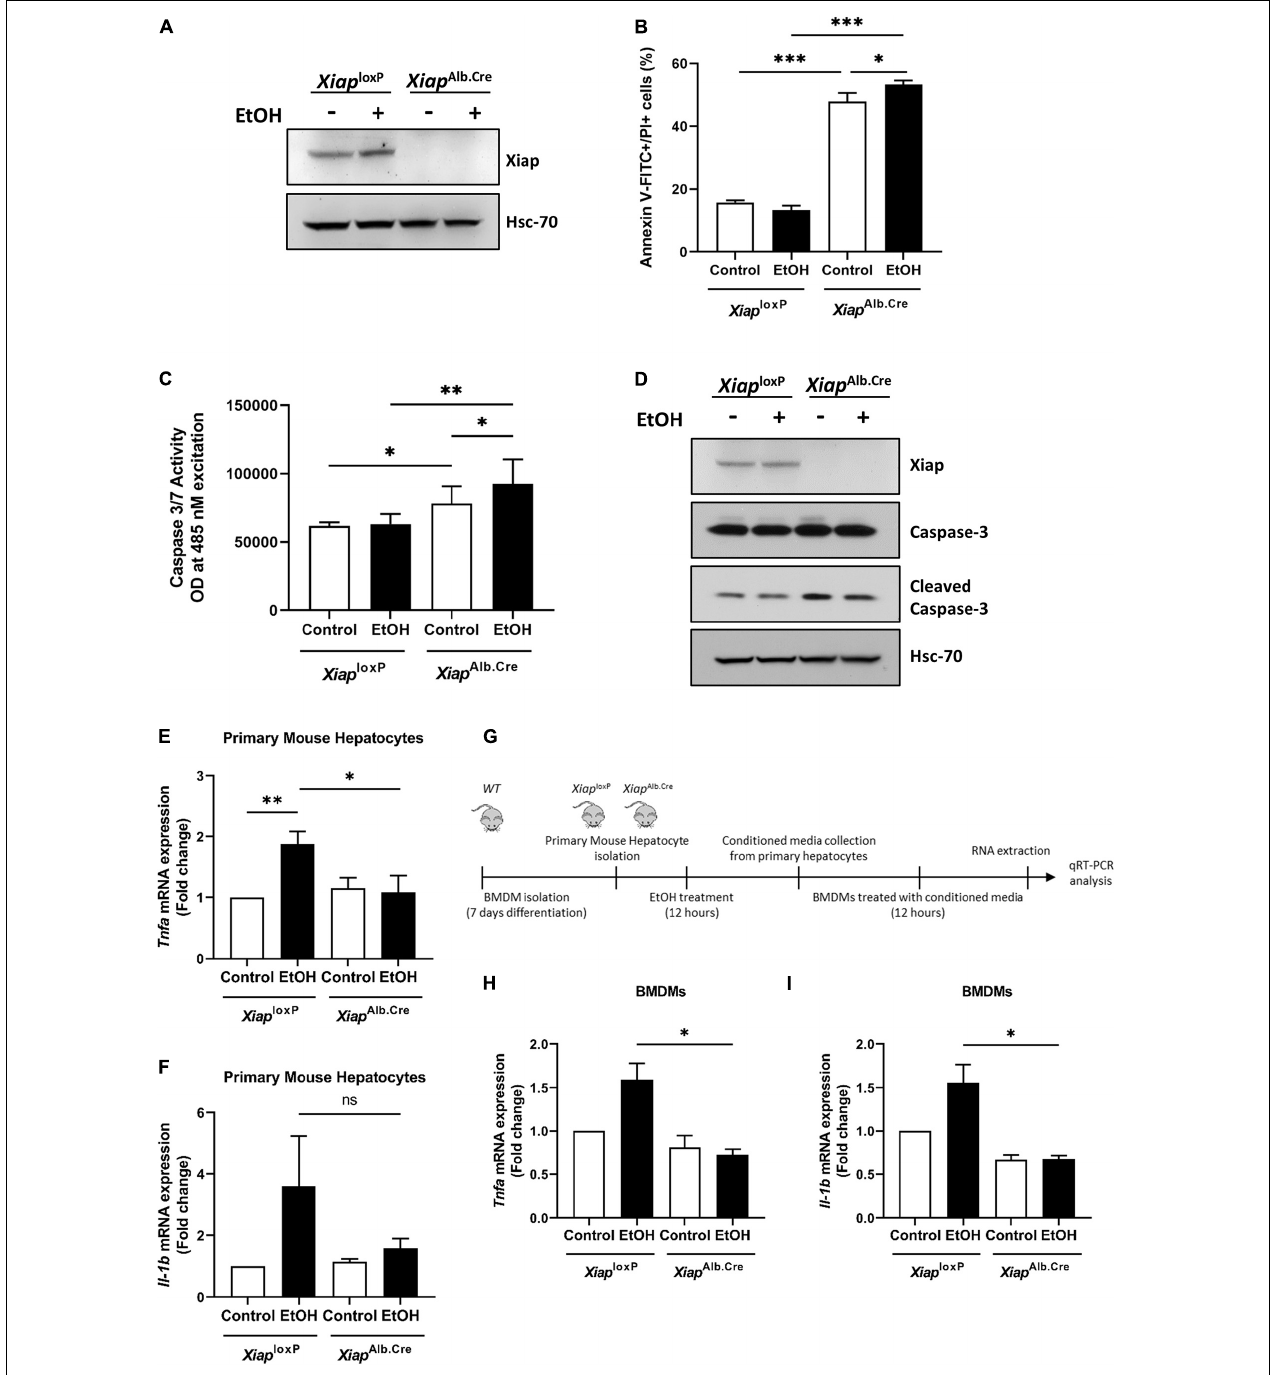
FIGURE 2 | Hepatocyte-selective knockout of Xiap modulates apoptosis and inflammation in PMH. (A) Evaluation of Xiap deletion in primary hepatocytes isolated from Xiap loxP and Xiap Alb . Cre mice after 12 h EtOH treatment. Xiap protein levels were determined by Western blot. Hsc-70 protein expression was used as a loading control for total protein. (B–D) Evaluation of the effect of Xiap deletion in apoptosis by analyzing Anexin V-FITC+PI+ (B) , Caspase 3/7 activity (C) , and cleaved Caspase-3 protein expression (D) in primary hepatocytes isolated from Xiap loxP and Xiap Alb . Cre mice following EtOH treatment for 12 h. (E,F) Analysis of the effect of Xiap deletion in inflammation by quantifying relative mRNA levels of Tnfa (E) and Il-1b (F) by qRT-PCR in primary hepatocytes isolated from Xiap loxP and Xiap Alb . Cre mice following EtOH treatment for 12 h. Gapdh was used as a housekeeping gene. (G) Schematic work flow for PMH experiments showed in panel (H) and panel (I) . (H,I) qPCR analyses of the relative mRNA levels of Tnfa (H) and Il-1b (I) in BMDMs incubated with conditioned media collected from Xiap loxP - and Xiap Alb . Cre mice-primary hepatocytes treated with or without EtOH. Gapdh was used as a housekeeping gene ( ∗ p < 0.05; ∗∗ p < 0.01; ∗∗∗ p < 0.005; ns, no significance, and n =